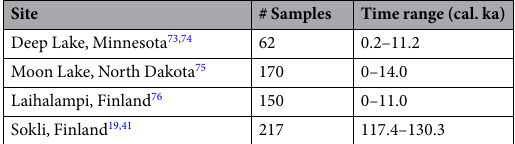
Table 1. Fossil pollen datasets used for the study.